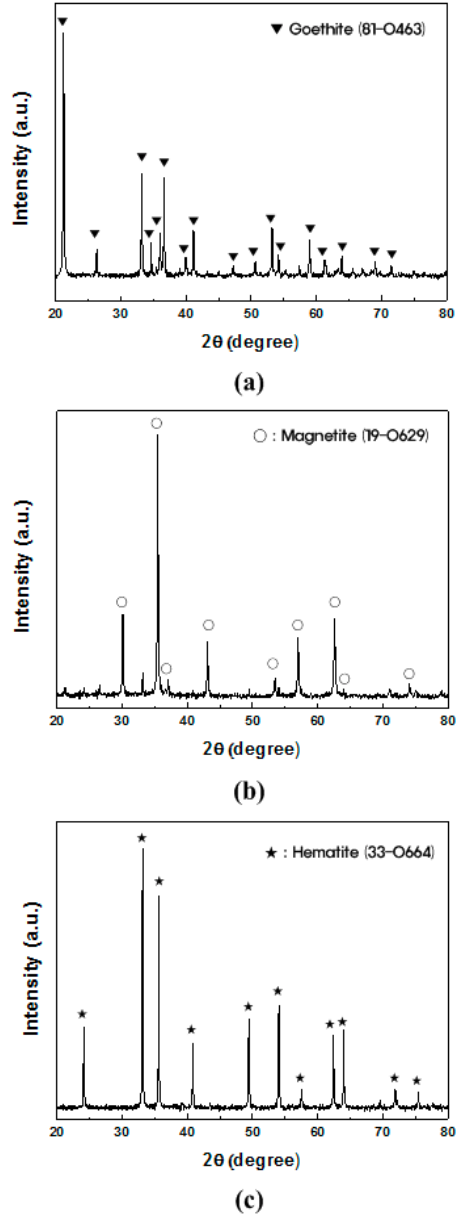
Figure 1. X-ray diffraction results of iron oxide powder used as deposit materials: ( a ) α -FeOOH; ( b ) Fe 3 O 4 ; ( c ) Fe 2 O 3 .